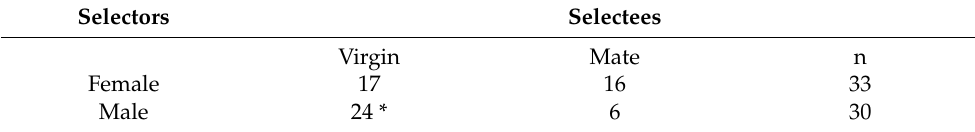
Table 4. Influence of mating status on A. curvicauda mate selection. All insects were 6–8 d. Selectors Selectees Virgin Mate n Female 17